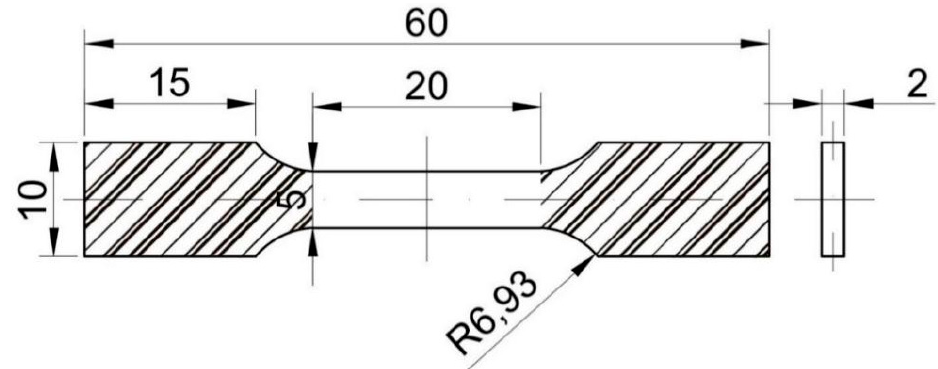
Figure 1. Dimensions of plate tensile samples (mm). Shaded areas were covered with paraffin wax.